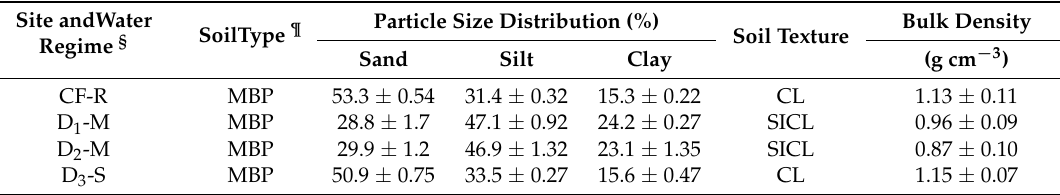
Table 2. Some chemical characteristics of the investigated paddy field soil profile (initial soil at 0–50 cm depth).